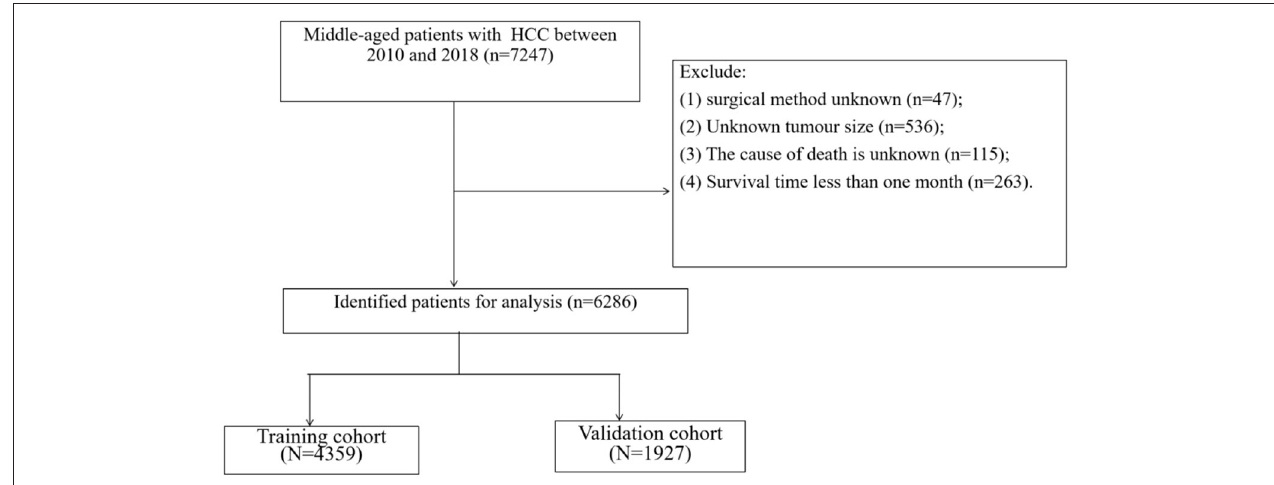
FIGURE 1 | Flow chart of patient